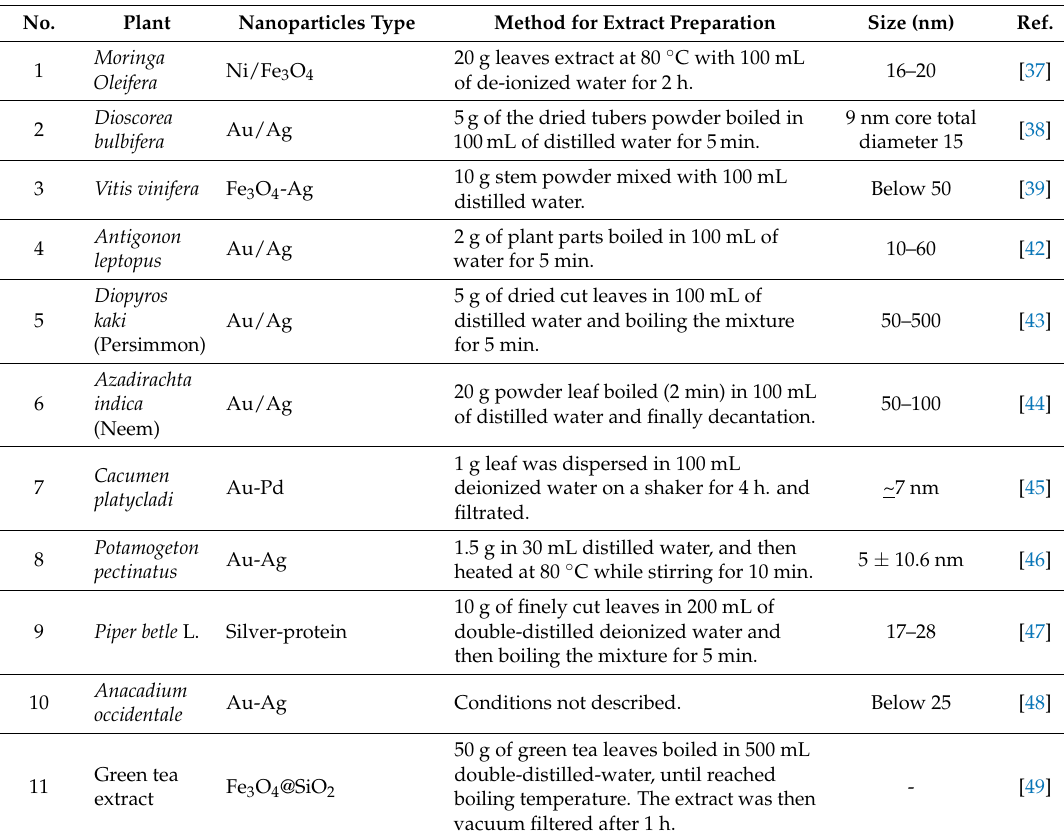
Table 2. Biosynthesis of core shell nanoparticles using